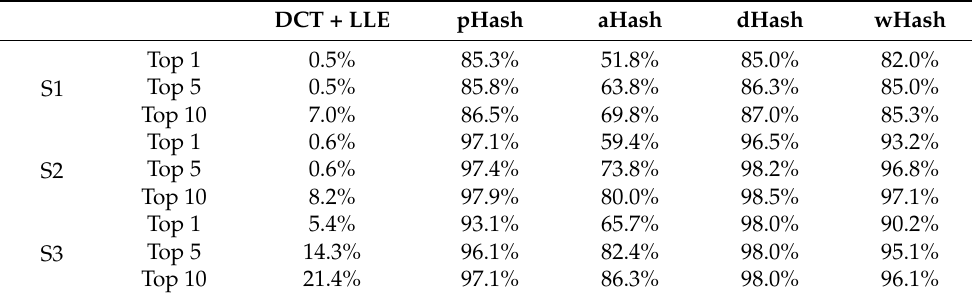
Table A9. Correct matches results for database vs. TS1 comparison—1024 bits.